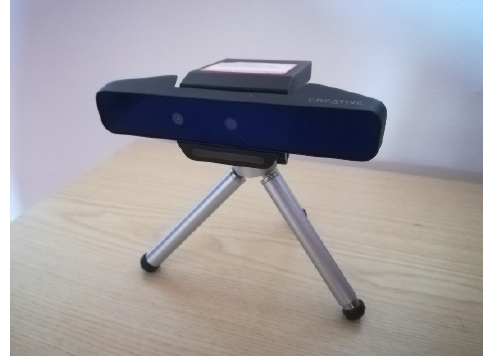
Figure 2. Intel RealSense SR300.